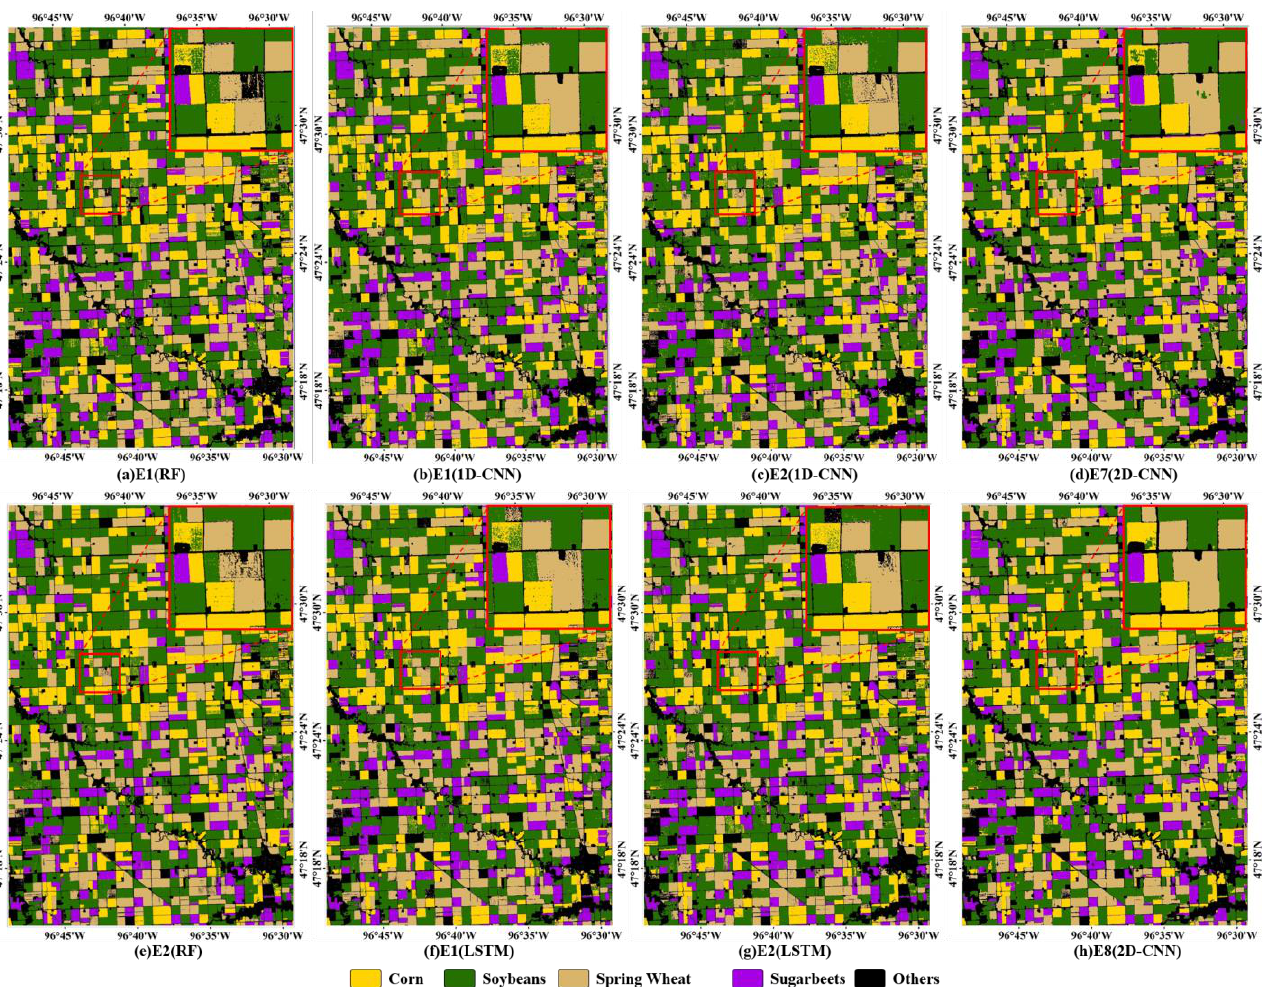
Figure 5. Crop classification results based on VI time-series (see red boxes for more